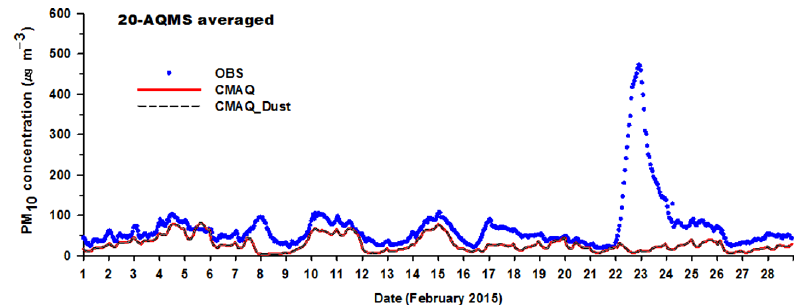
Figure 3. Time series of observed (OBS: blue dots) and simulated (CMAQ: red line, CMAQ_Dust: black dashed line) PM 10 concentrations in February 2015. The values are averaged values for 20 AQMS sites: CMAQ_Dust is closely coupled with the standard CMAQ modeling results (red